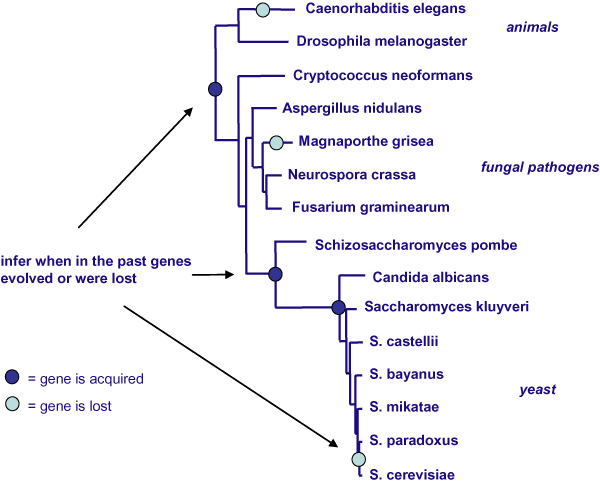
Phylogenetic tree of eukaryote species. Phylogenetic tree of fifteen eukaryote species used in this study (after Barker and Pagel, [10]). Dark blue dots illustrate hypothetical instances of a gene evolving and its protein entering the network; light blue dots illustrate instances of a gene and its protein being lost from the network.